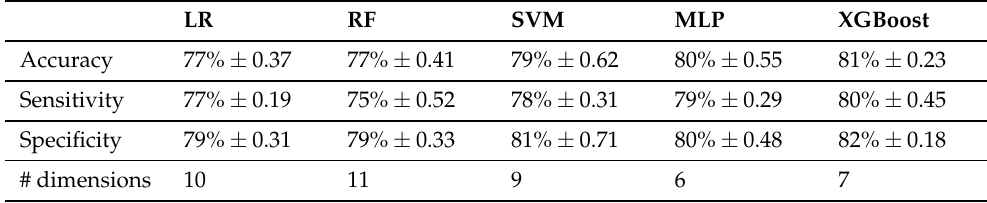
Table 5. Quantitative evaluation of the second stage of our system when PCA method is the feature reduction scheme. The values are average accuracy ± standard